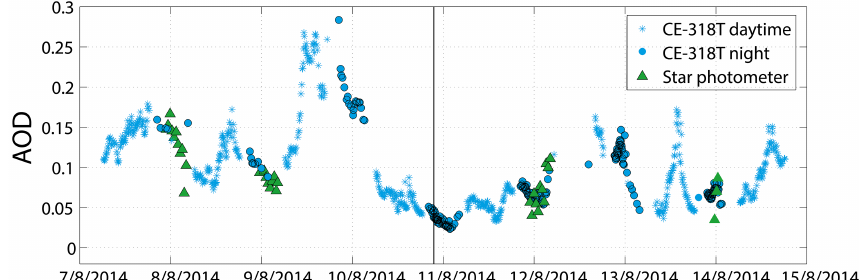
Figure 7. AOD at the 500nm channel from CE318-T in the daytime and night-time (in blue), and from the star photometer (in green) at Granada in 8 consecutive days in August 2014. Vertical line represents the full moon phase.